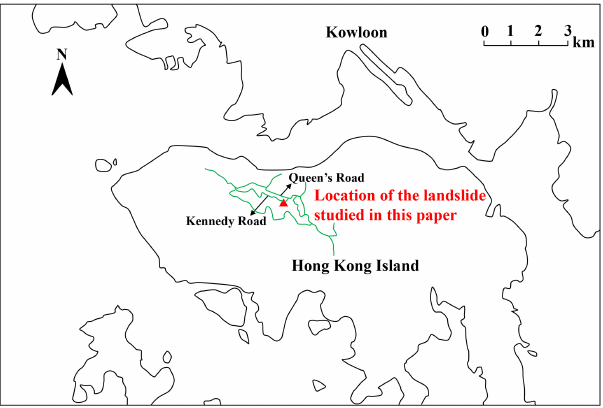
Figure 1. Location of the landslide studied in this paper.